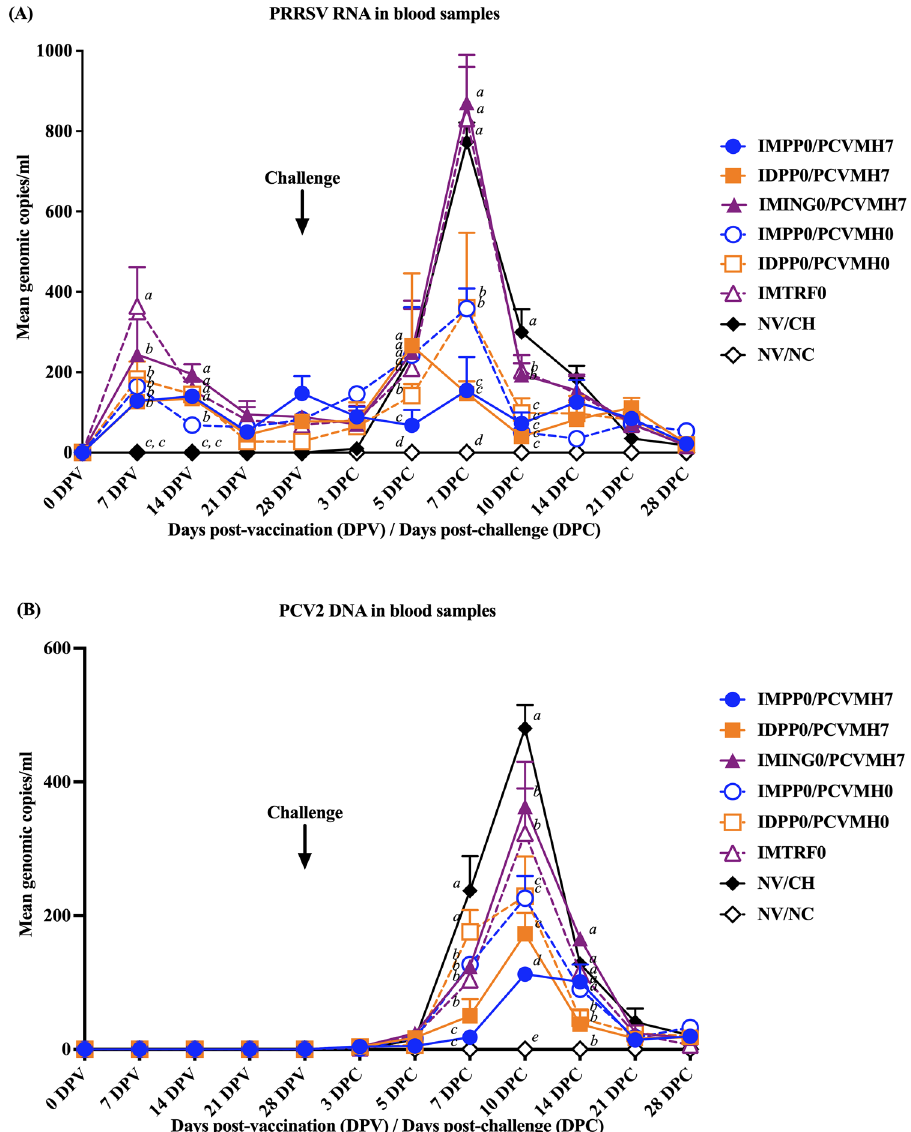
Figure 5. Mean genomic copies of ( A ) PRRSV RNA and ( B ) PCV2 DNA in the blood samples. Values expressed as mean ± SEM. The results were compared using two-way ANOVA for multiple comparisons. Different lowercase letters (a–c) indicate significant differences between treatment groups ( p < 0.05) for each